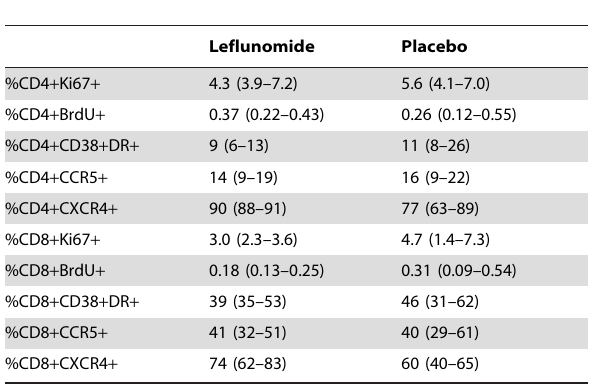
Table 2. Participant baseline levels of turnover, activation and coreceptor expression A (median value with interquartile range in